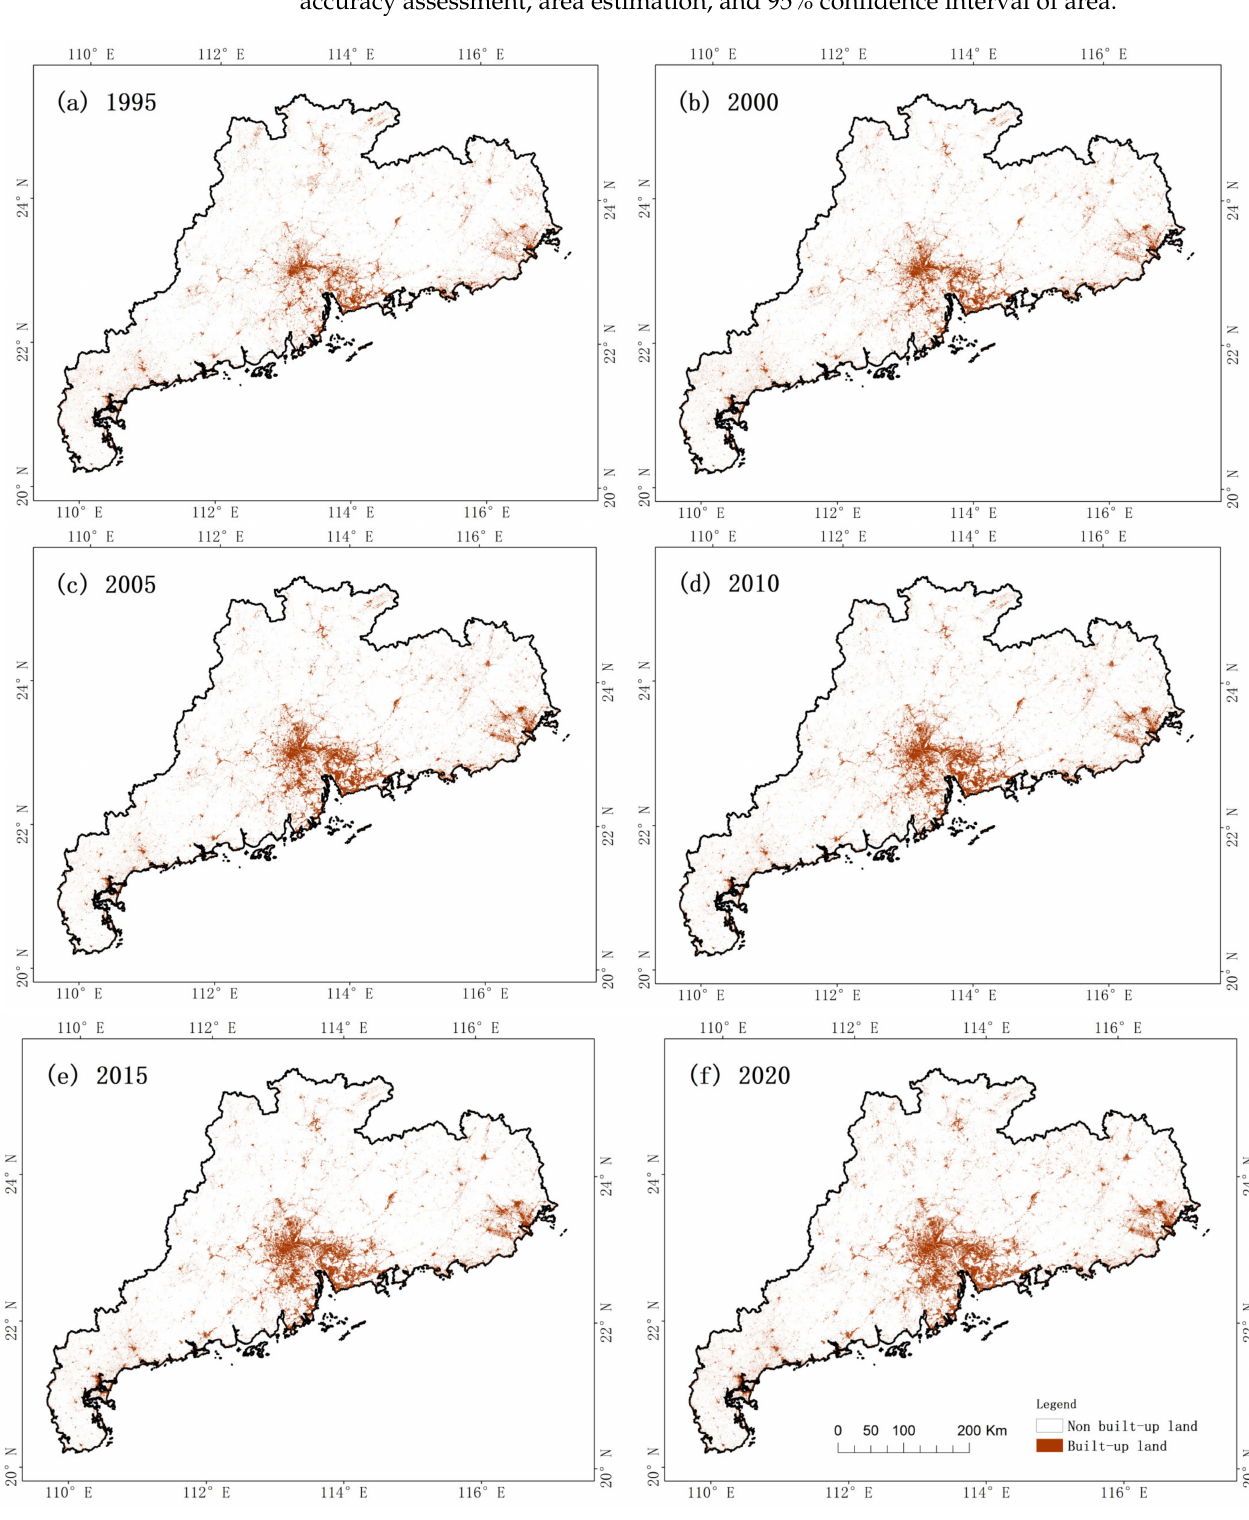
Figure 12. Annual built-up land maps of Guangdong, China in 1995, 2000, 2005, 2010, 2015,